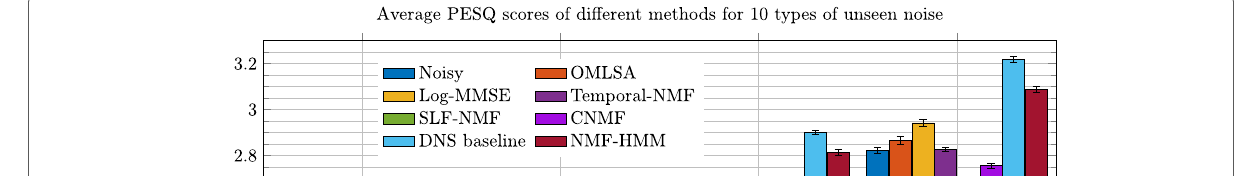
Fig. 2 Average PESQ scores of different methods for 25 types of seen noise